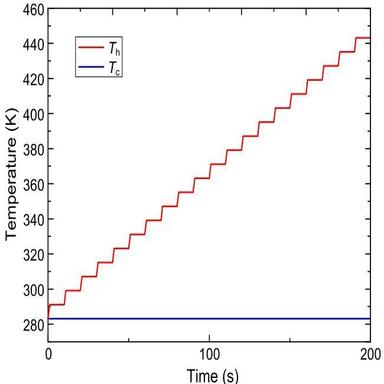
The boundary temperatures of the TEG module needed by the modified quasi-steady state (QSS) method.